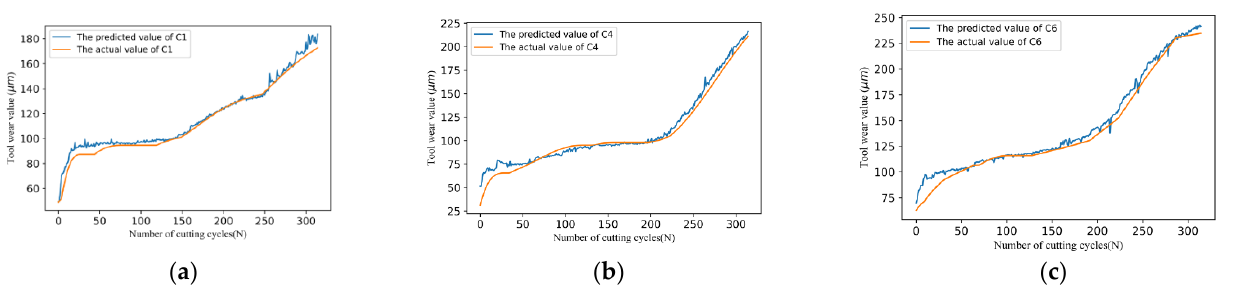
Figure 7. Prediction result of MSCNN model on datasets. ( a ) C1, ( b ) C4, and ( c ) C6. 𝑃 𝑀𝐴𝐸 = 5.65 , 𝑃 𝑀𝑆𝐸 = 49.13 .